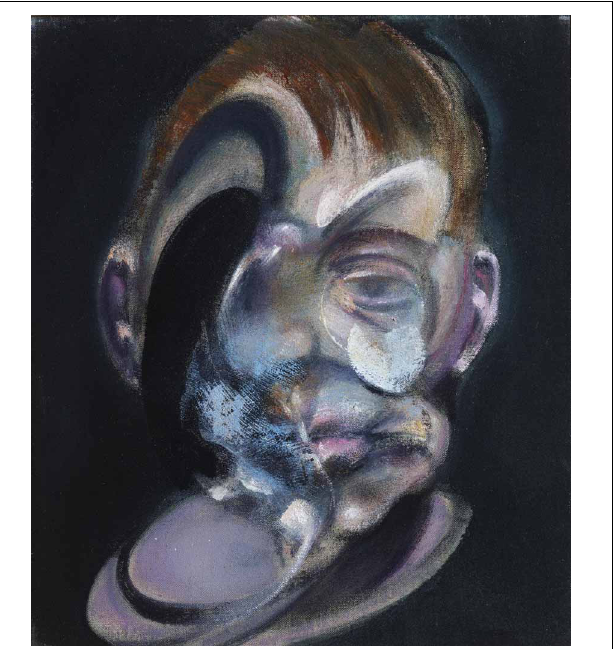
FIGURE 6 | Francis Bacon— Self Portrait, 1973. © The Estate of Francis Bacon. All rights reserved. DACS